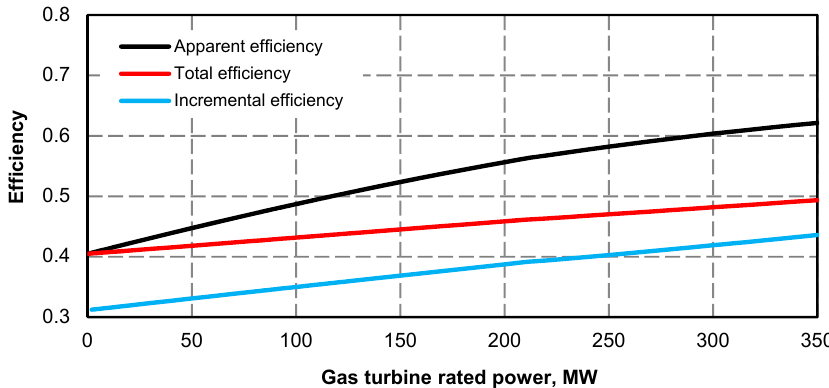
Figure 9. The energy efficiency for the power unit with superstructure added as a function of gas turbine rated power for a maximum fixed stream of 319.4 kg/s fresh steam fed to the steam turbine.